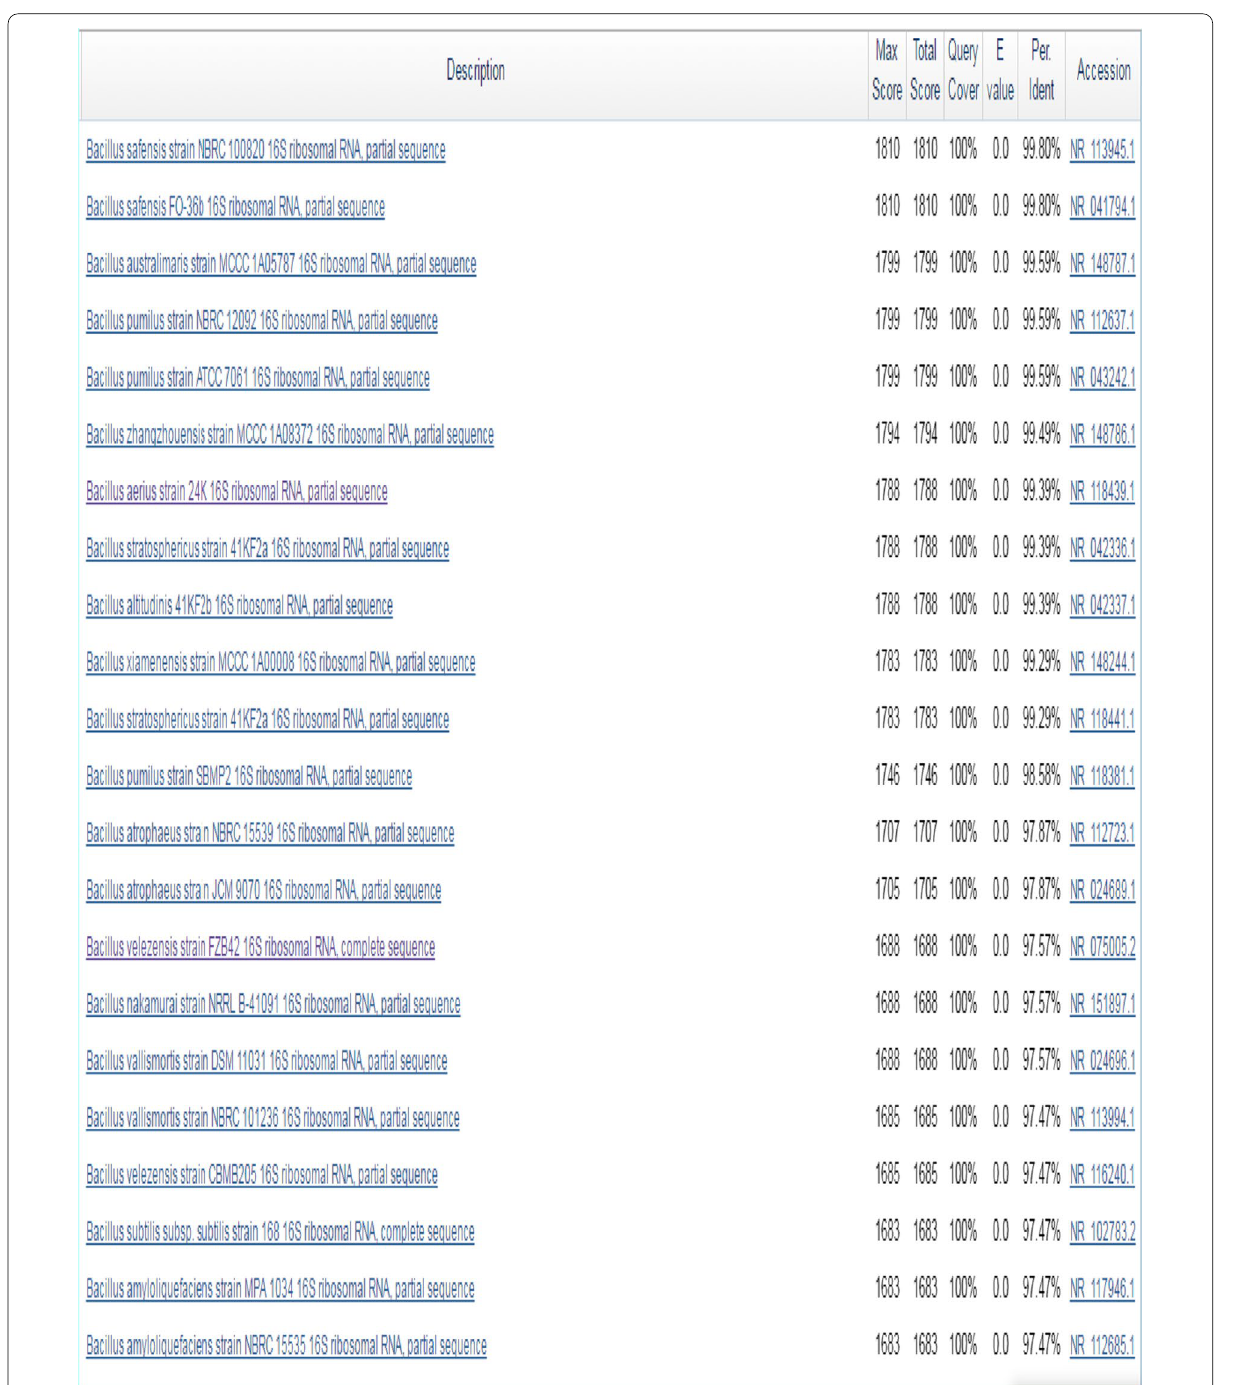
Fig. 2 16S ribosomal RNA gene of Bacillus safensis and its similarity